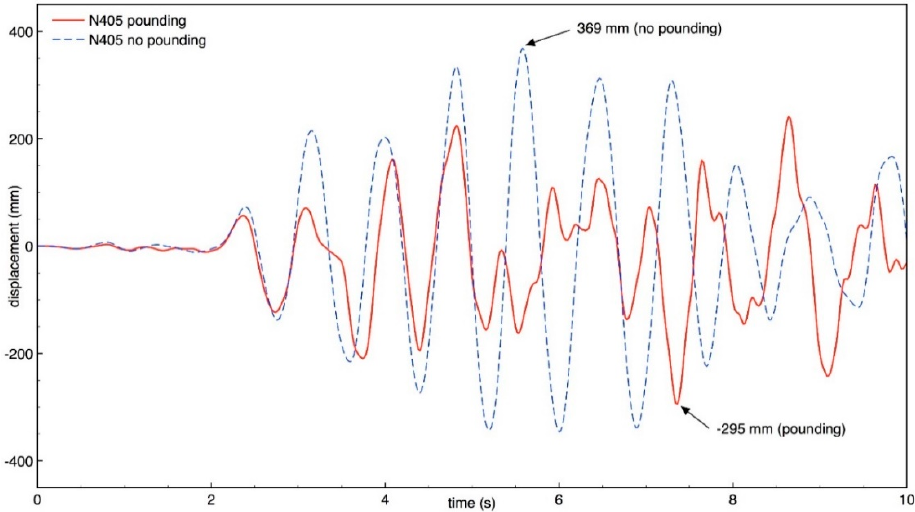
Figure 15. Longitudinal response of building B (node N405) with and without pounding.